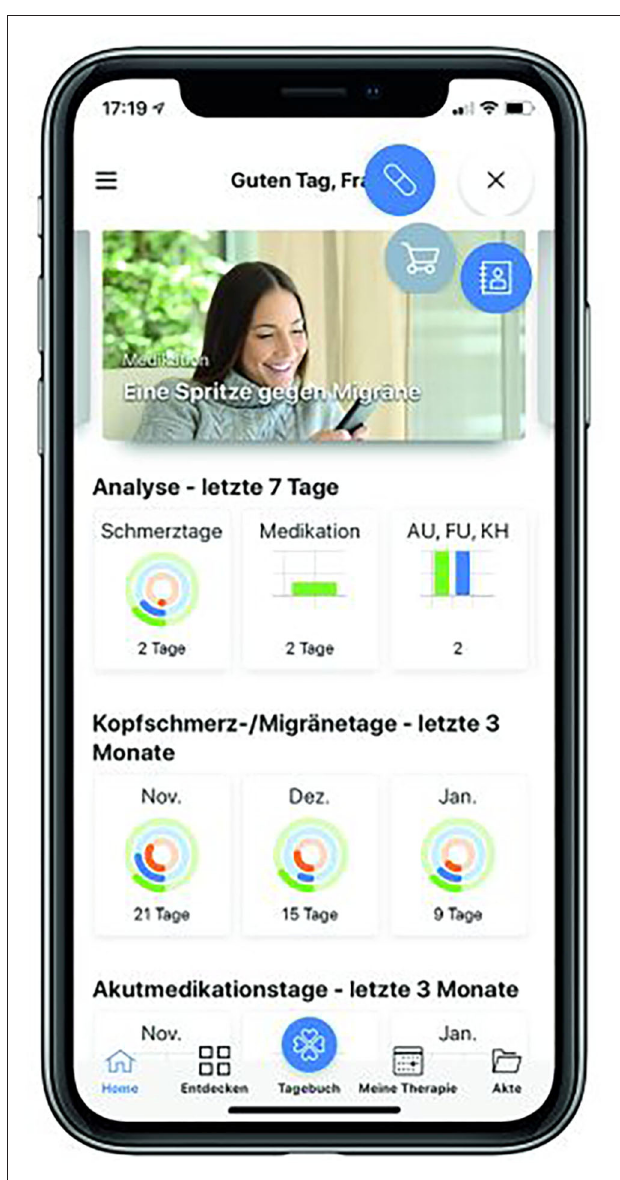
FIGURE 4 | My NTC health guide for migraine (The image depicting an identifiable individual was obtained from the public database